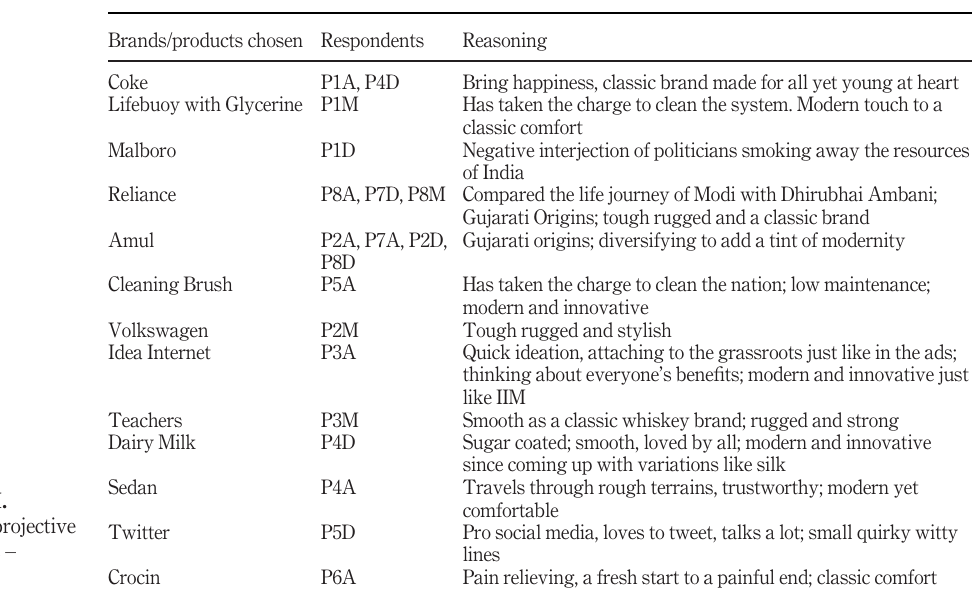
Table VII. Results – projective techniques –